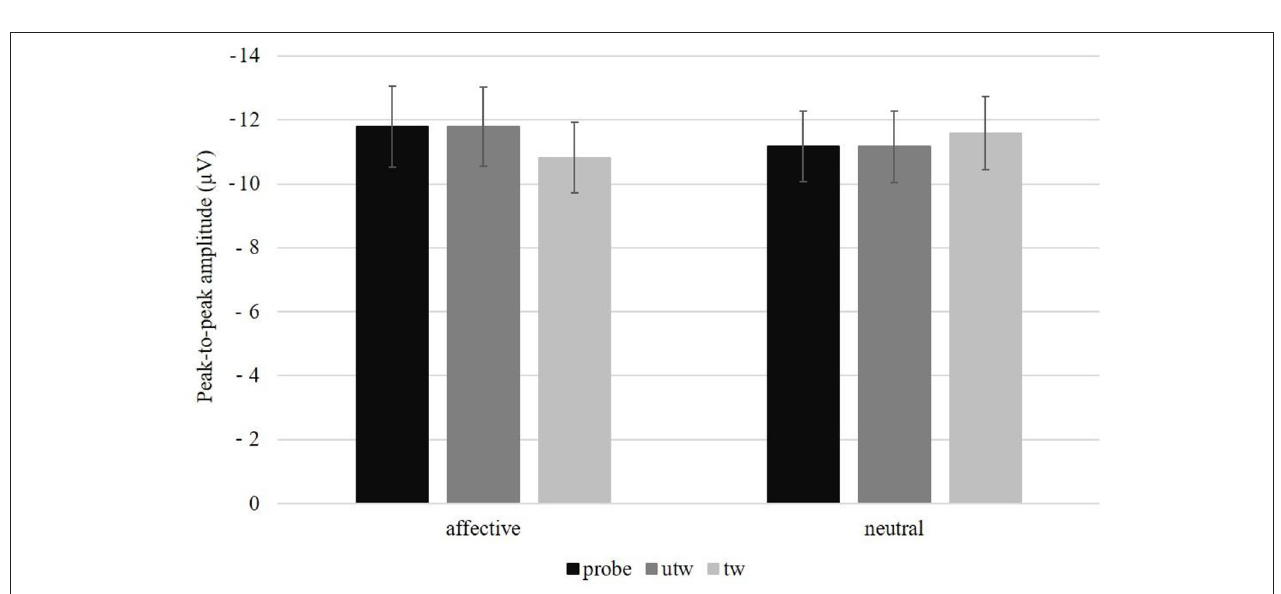
FIGURE 4 | Peak-to-peak amplitude in microvolt ( µ V) and standard errors averaged over electrode positions (Fz, FCz, Cz, Pz) per picture type and conditions (affective vs. neutral). probe, untrustworthy-probe; utw, truthful untrustworthy; tw, truthful trustworthy.